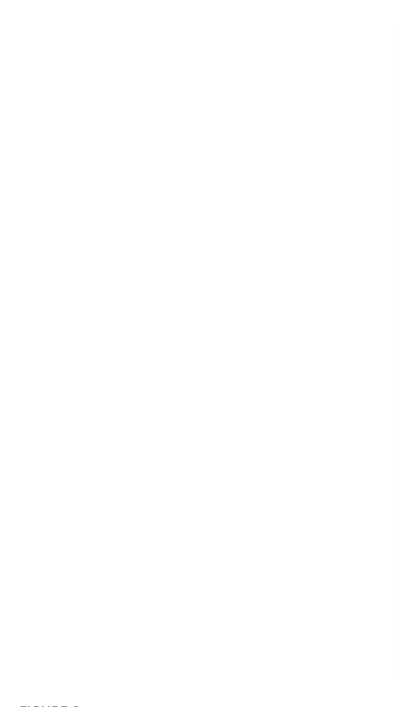
FIGURE 2 Study fl ame chart of the Mendelian randomization